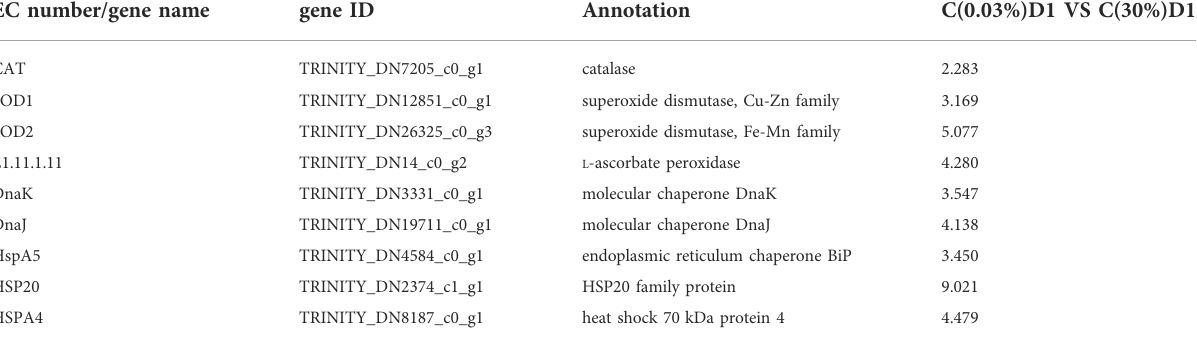
TABLE 3 Differential expression of key proteins in oxidative